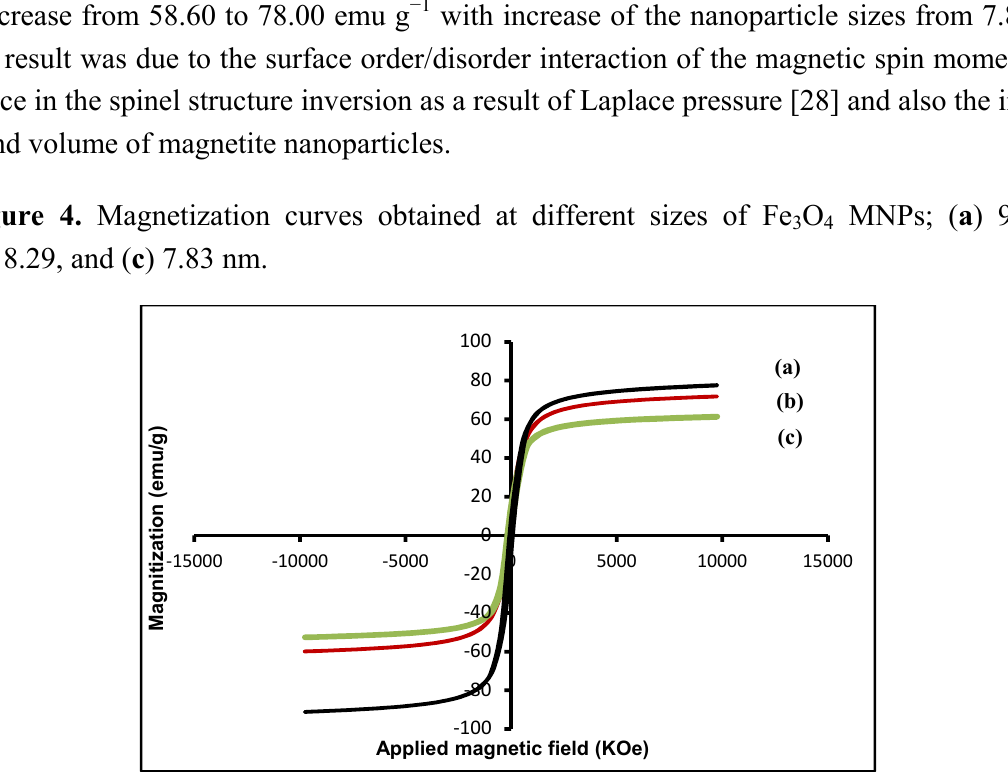
O MNPs; ( a ) 9.41, 3 4